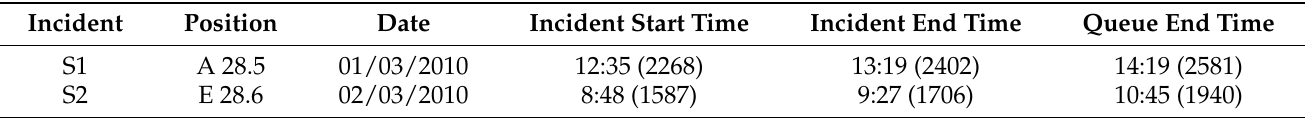
Figure 1. A miniature diagram of Attika Tollway showing the locations of the incidents relative to the positions of the sensors. Table 1. Positioning and timing of the incidents and their consequences as reported from the Traffic Management Centre